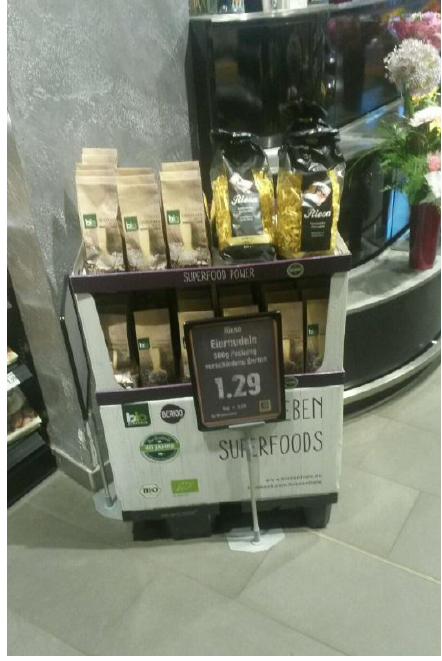
Figure 1. So-called superfoods can now be easily found in supermarkets.